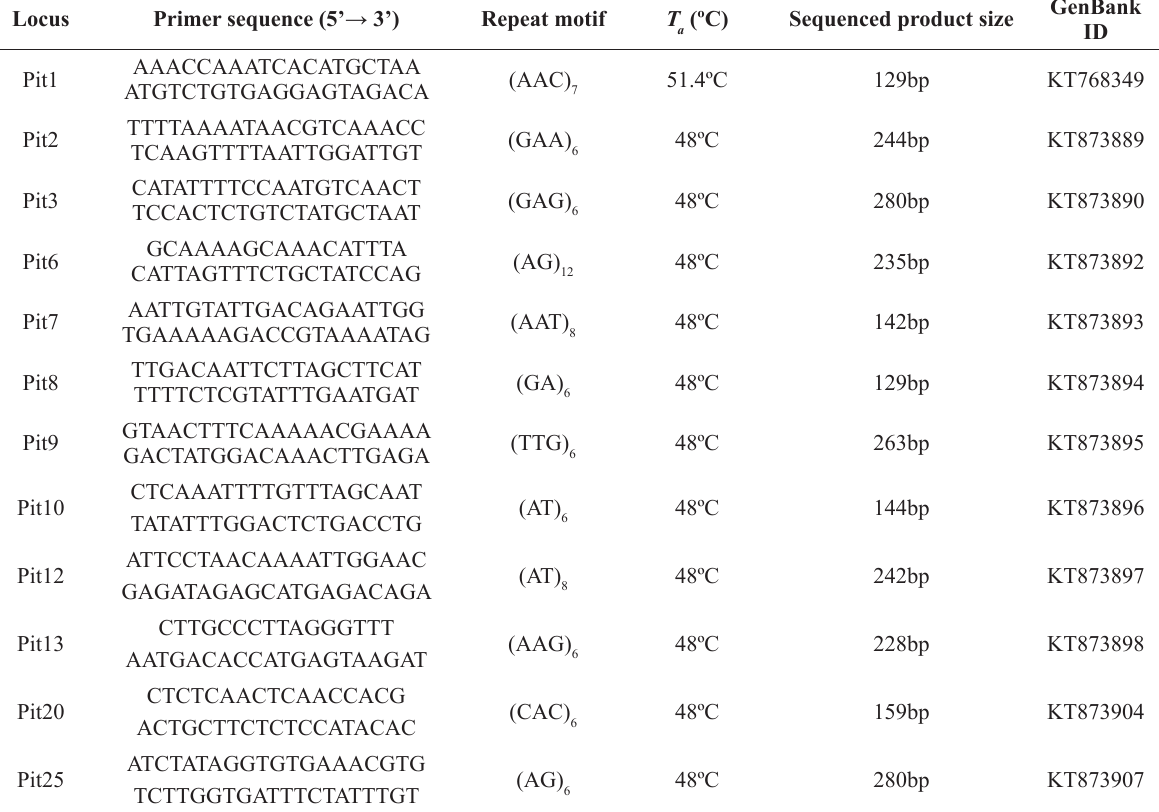
Characterization of 12 SSR markers for Eugenia uniflora including primers sequence (forward and reverse), repeat motif, annealing temperature (T ), length of the sequenced fragment, and GenBank accession number (GenBank a